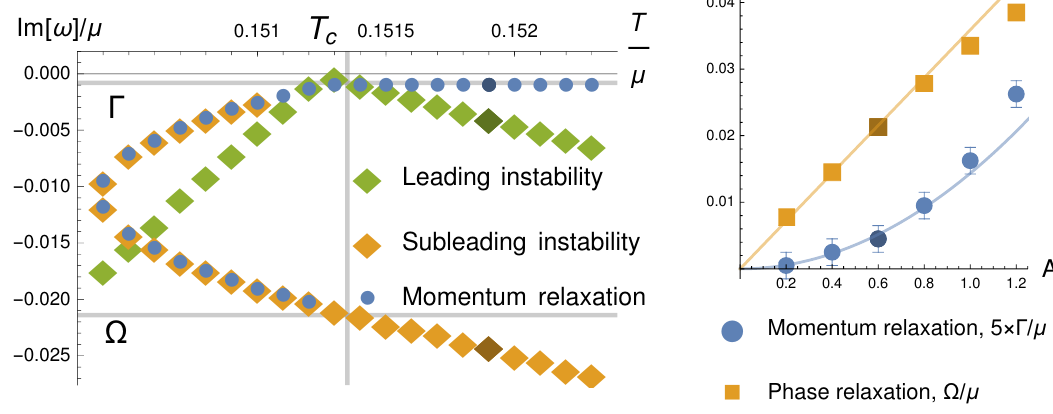
Figure 3. Left panel. Spectrum of the purely imaginary quasinormal modes in holographic model with periodic spontaneous structure at A = 0 . 6 , (3.3). The three modes are present above T . c They correspond to the two instability modes, which are split due to explicit symmetry breaking (green and yellow), and a momentum relaxation mode, corresponding to the Drude peak (blue). The positions of the modes are obtained from the study of corresponding 2-point functions, which define the coloring. Below T the leading instability triggers a phase transition and moves away, c while the subleading instability plays a role of the damped Goldstone mode and mixes with the momentum relaxation mode, according to [38]. This mixing is evident from the fact that both modes appear in different correlators — the blue and yellow dots overlap. Note the close similarity with time-dependent Ginzburg-Landau prediction, figure 1. At lower temperature the two imag- inary modes collide and form a pair of real-valued modes, corresponding to propagating massive pseudo-Goldstone [34]. The darker markers represent the modes shown on figure 4. Right panel. The dependence of parameters on the amplitude of the ionic lattice, A , which corre- sponds to the scale of explicit symmetry breaking. For A . 0 . 6 , the phase relaxation rate Ω (yellow) scales linearly Ω ∼ A , in agreement with (2.9). The behavior of the momentum relaxation rate Γ ∼ A 2 is also shown. The darker markers correspond to A = 0 . 6 , which is shown on the left